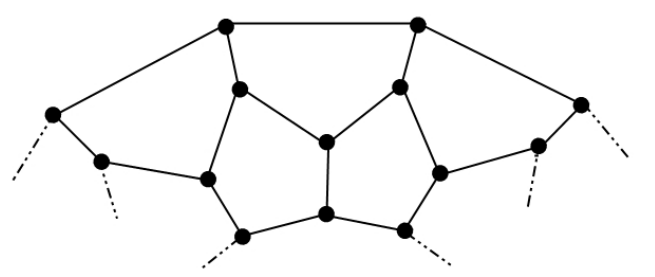
Figure 4. The graph of convex polytope D n